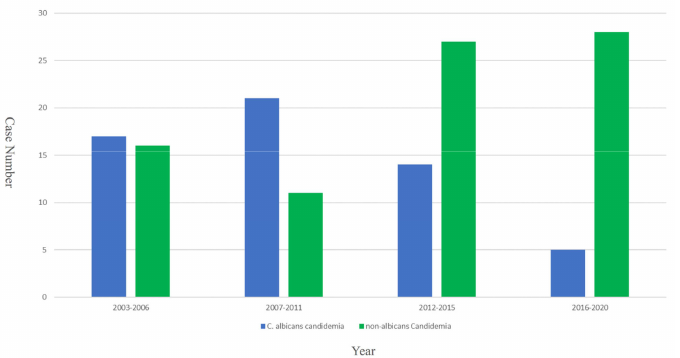
Figure 1. The increasing trend of non-albicans candidemia in the neonatal intensive care unit of Chang Gung Memorial Hospital, 2004–2020. Table 2. Minimum inhibitory concentration distributions of six antifungal agents to all